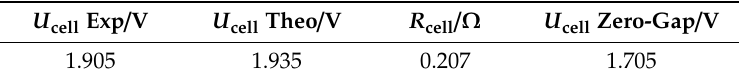
Table 4. Theoretical and experimental cell voltage using Ra–Ni and SS316L electrodes (75 ◦ C, 1 atm. 300 mA cm − 2